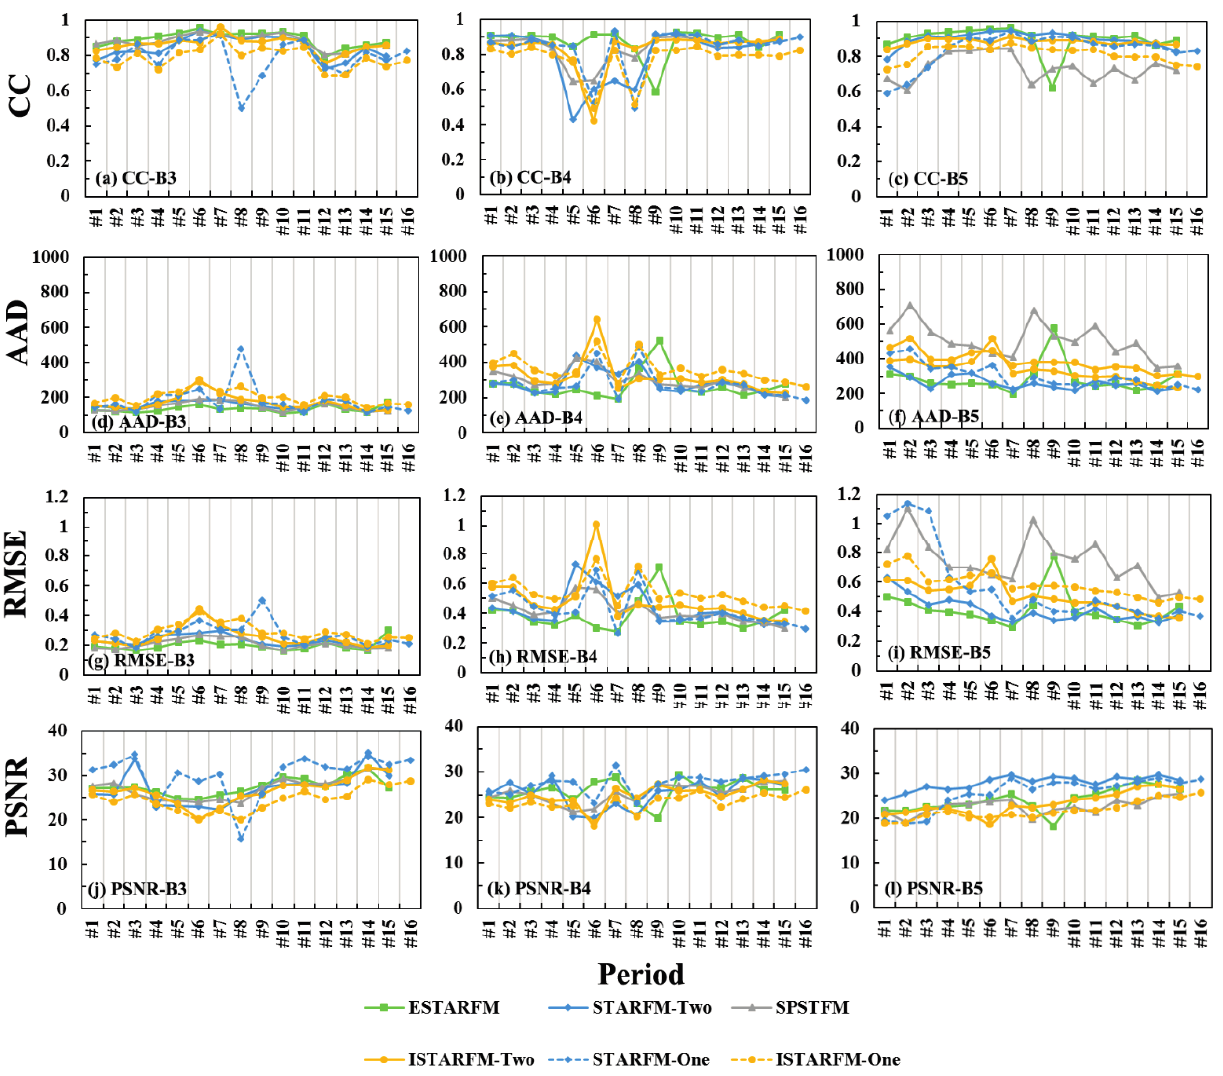
Figure 9. “Curve” visualization of the individual accuracy measures of the time-series predictions for the CIA site, showing the accuracy measures: CC ( a – c ); AAD ( d – f ); RMSE ( g – i ); and PSNR ( j – l